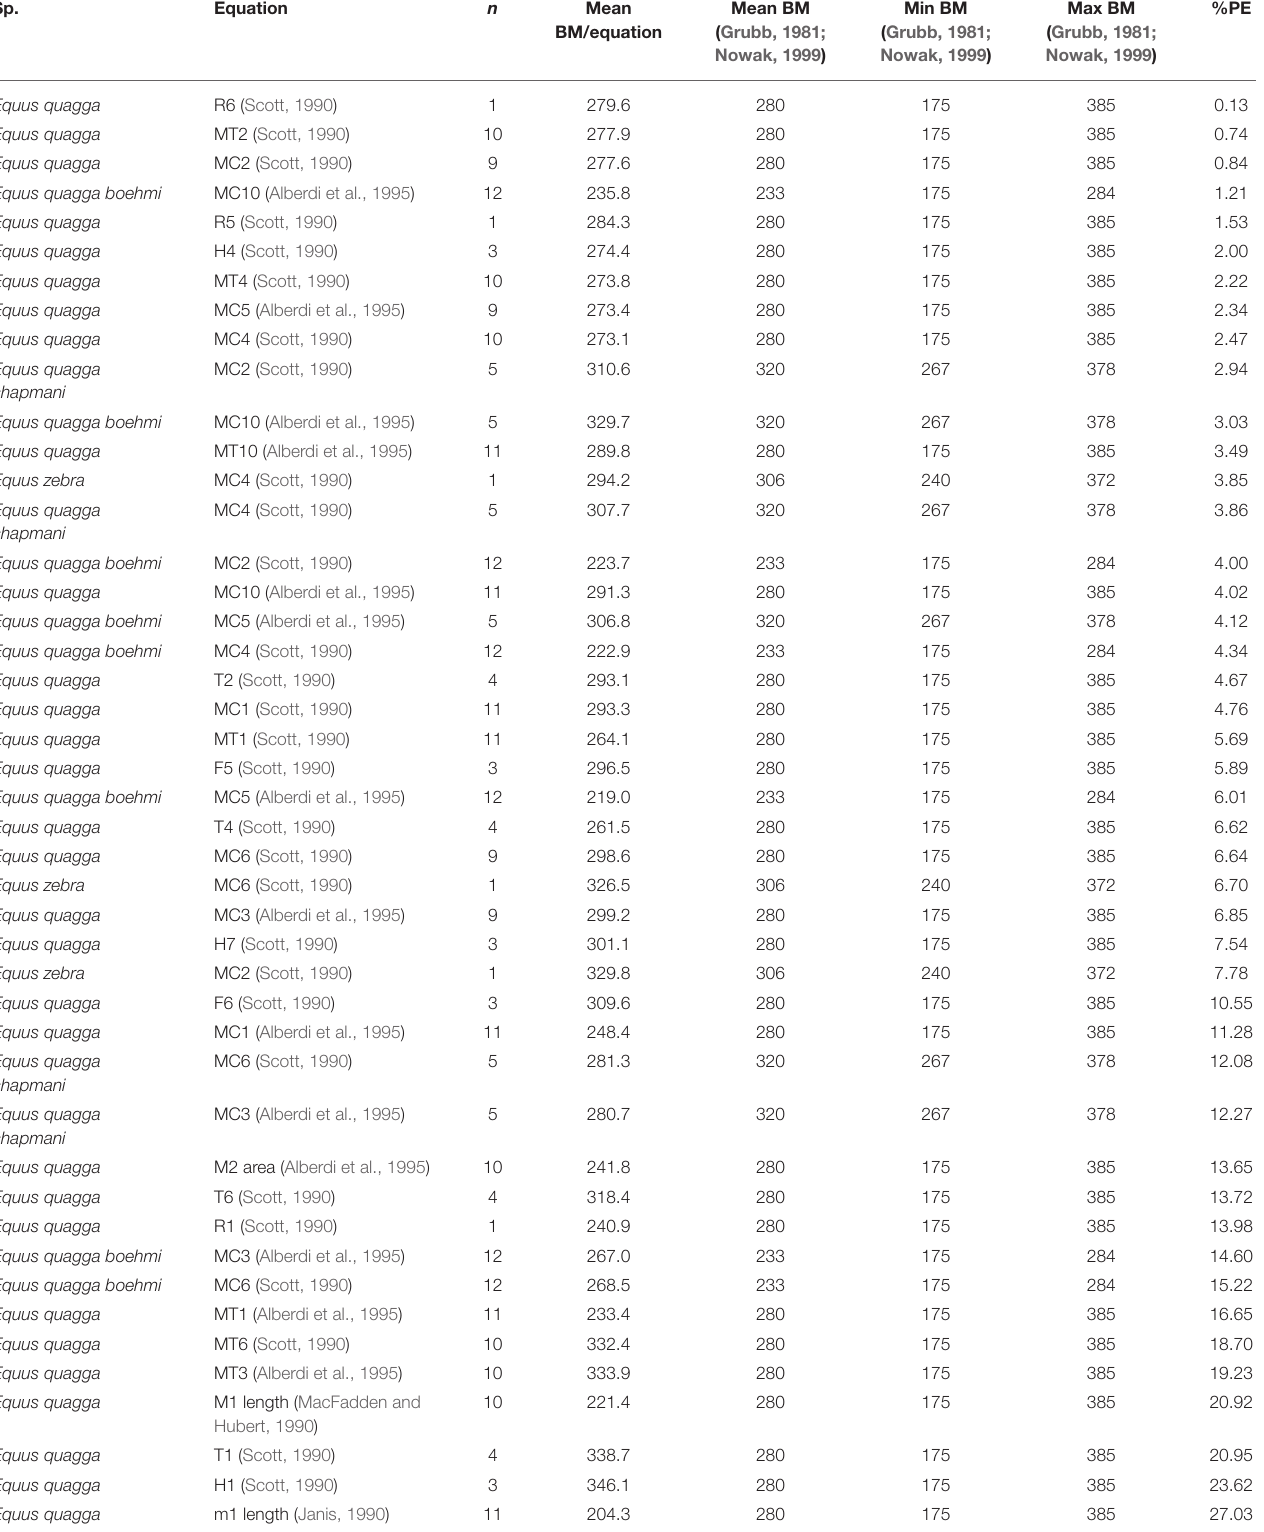
TABLE 1 | Body mass estimation equations ranked from “best” to “worst” based on percent prediction error (%PE) for skeletal and dental measurements of Equus quagga, the subspecies E. quagga boehmi and E. quagga chapmani and E. zebra . Sp.